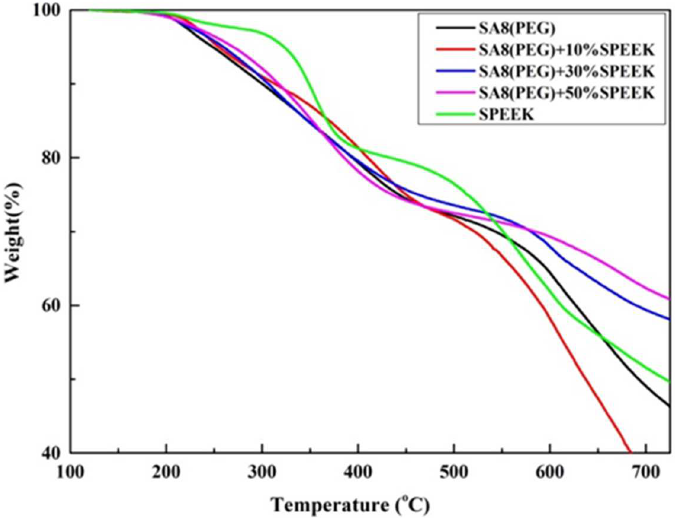
Figure 15. TGA diagram of SA8 polymer blended with PEG and